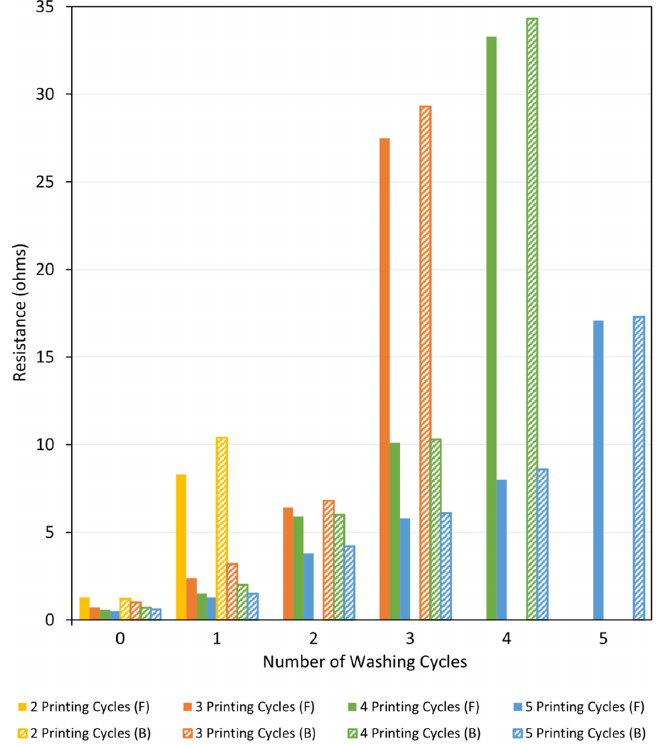
Figure 13. Resistance of the face (F) and back (B) side of the metallised samples printed with the Cu–Ag NP catalyst at different numbers of cycles in the warp direction versus number of washing cycles.